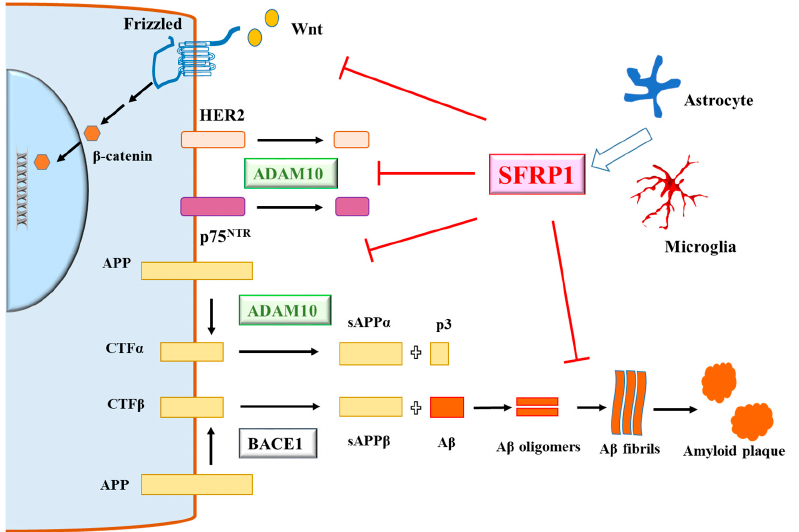
Figure 1. A schematic diagram illustrating the possible roles of secreted-frizzled-related protein 1 (SFRP1) in Alzheimer’s disease (AD). Astrocyte- and microglial (and other cell types)-secreted SFRP1 inhibit metalloproteinase domain-containing protein (ADAM10)-mediated non-amyloidogenic processing of amyloid precursor protein (APP). SFRP1 could also interfere with fibril / protofibril formation by amyloid β (A β ), thus potentially preserving A β oligomers. SFRP1 also inhibits Wnt signaling, which is important for neuronal function and synaptic integrity. On the other hand, SFRP1 could be tumor suppressive via its inhibition of ADAM10’s sheddase activity, which liberates the ectodomain of growth / metastasis promoting proteins such as human epidermal growth factor receptor 2 (HER2) and the low a ffi nity neurotrophin receptor (p75 NTR ). See text for more